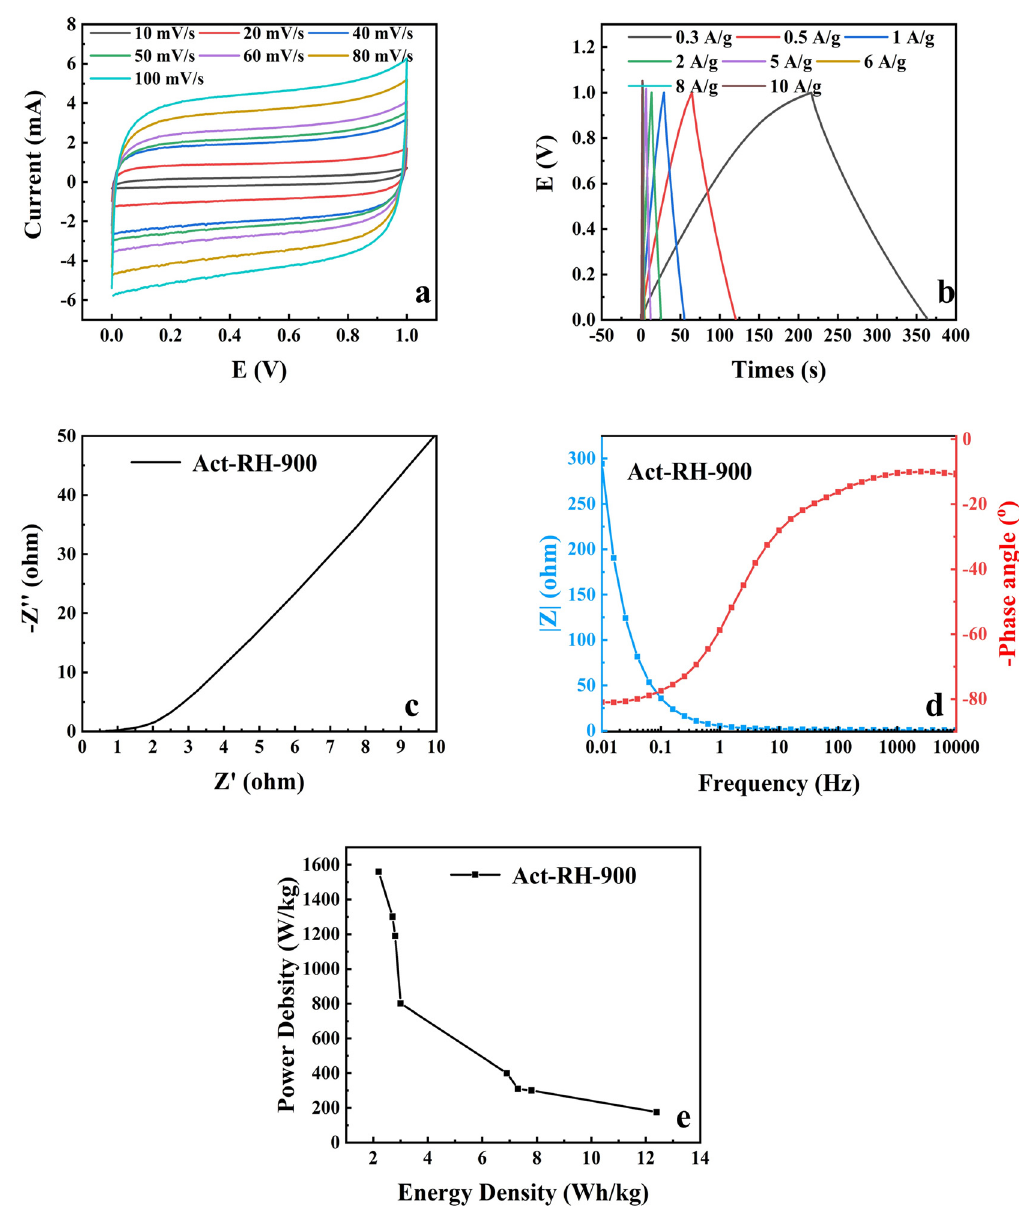
Figure 9. Electrochemical performances of Act-RH-900//Act-RH-90 tested in the two-electrode system. ( a ) CVs of Act-RH-900 at scan rates from 10 to 100 mV s − 1 . ( b ) GCD results for Act-RH-900 at current densities from 0.3 to 10 A g − 1 . ( c ) EIS results for Act-RH-900. ( d ) Bode phase angle and electrochemical impedance plots of Act-RH-900. ( e ) Ragone plot for Act-RH-900.